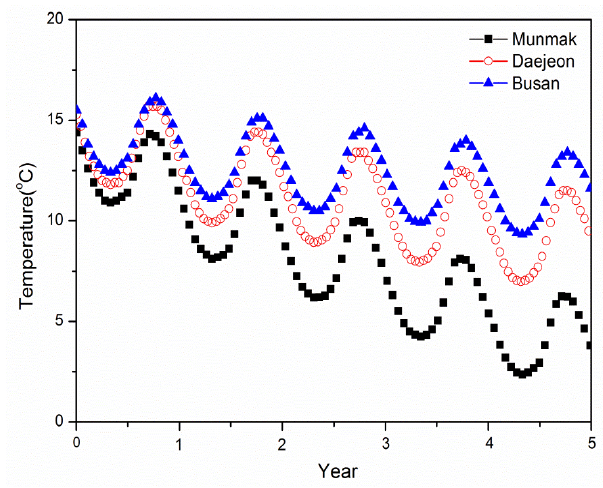
Figure 5. Variation of ground mean